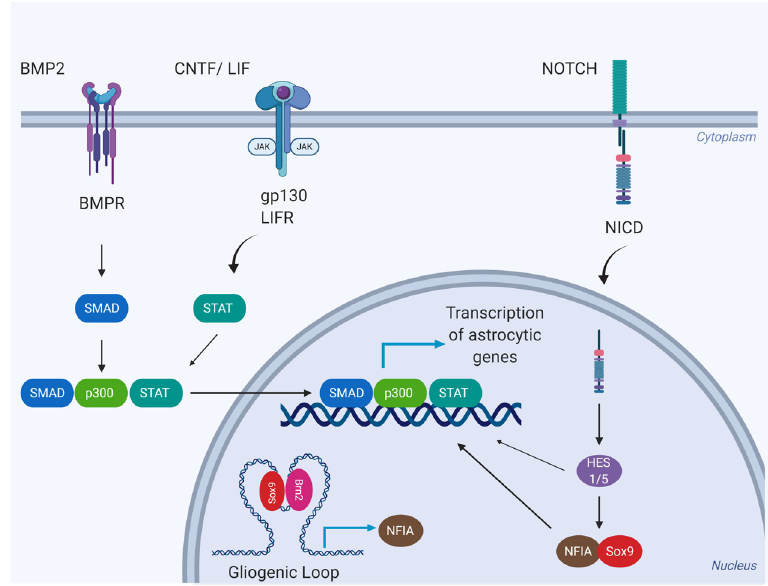
Figure 1. Molecular signaling pathways involved in astrocytogenesis. Neural stem cells (NSCs) express astrocytic genes in response to several signaling molecules, including bone morphogenic protein (BMP) families, the leukemia inhibitory factor/ciliary neurotrophic factor (LIF/CNTF), and Notch pathway. BMPs signal primarily through SMAD, whereas LIF/CNTF activates the JAK/STAT pathways. The active SMAD–STAT complex bridged by p300 goes directly into the nucleus, binds to the promoter, and activates astrocytic genes such as GFAP and S100 . Another important pathway that regulates astrocytogenesis is the Notch pathway. Notch ligands will activate Notch receptors and activate the expression of Hes genes, Hes1/5 . Hes1, Hes5, and activated forms of Notch receptors induce the expression of astrocytic genes and glial promoting transcription factor nuclear factor-I A (NFIA). In early development, a pre-formed gliogenic loop serves to facilitate the association between sex-determining region Y-box 9 (Sox9) and brain-specific homeobox/POU domain protein 2 (Brn2), which also drives expression of NFIA. NFIA is both necessary and sufficient for the induction of astrocytic